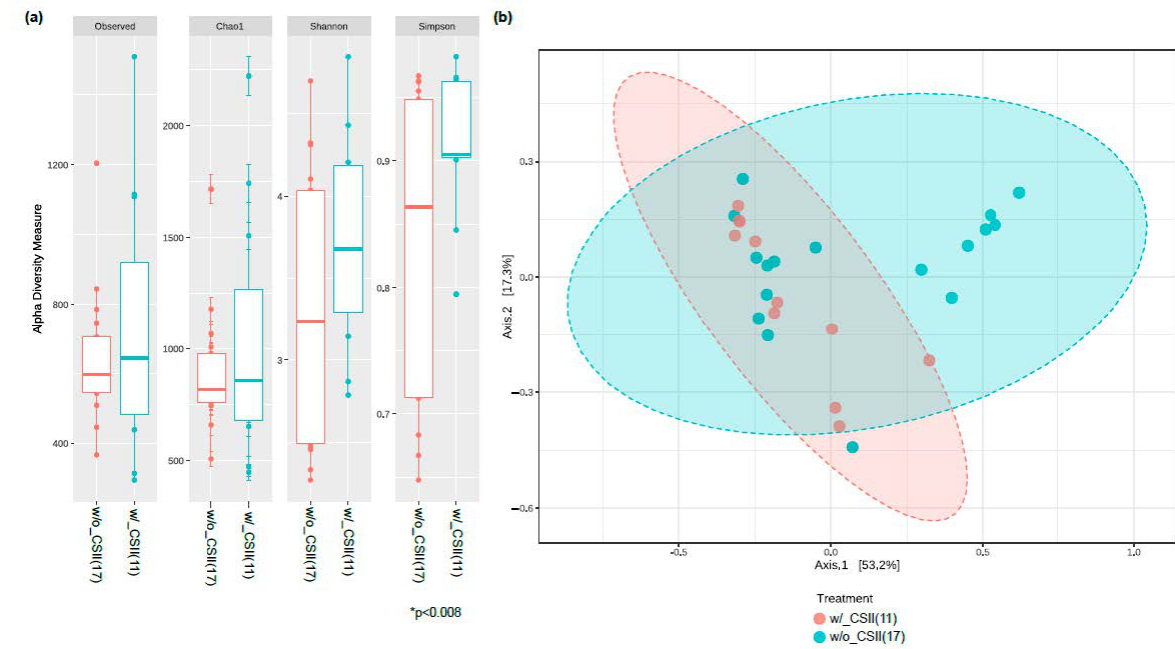
Figure 1. Effect of CSII therapy on the gut microbiome composition in the T1DM subjects. ( a ) The gut microbial diversity index measured by alpha diversity revealed that the subjects who had CSII therapy had higher microbial abundance (only in Simpson index). ( b ) There were no microbial dissimilarities (beta-diversity) in subjects with or without the CSII therapy. β -Diversity was visualized using Principle co-ordinations generated with the Bray–Curtis distance metric using QIIME. Analysis of group similarity (ANOSIM) was measured between categories included in this study using 1000 permutations, * p < 0.05. ( b ) Note: g UC, genus_unclassified; w/_CSII, with CSII therapy; w/o_CSII, without CSII therapy.